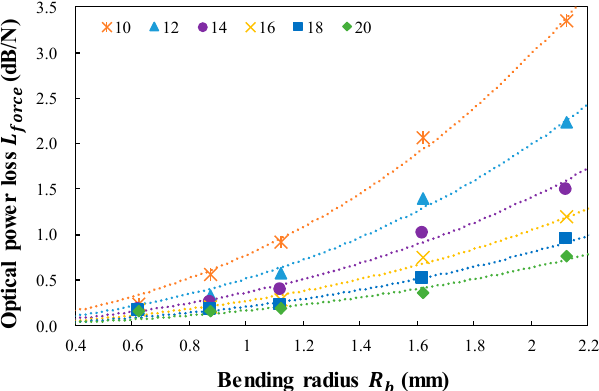
Figure 6. Calculated optical power loss per unit Newton ( L force ) determined by the spring tension load ( F s ) versus bending radius ( R b ) for six distances between steel wires ( d wire ) of the twisted dual-cycle bending structure.